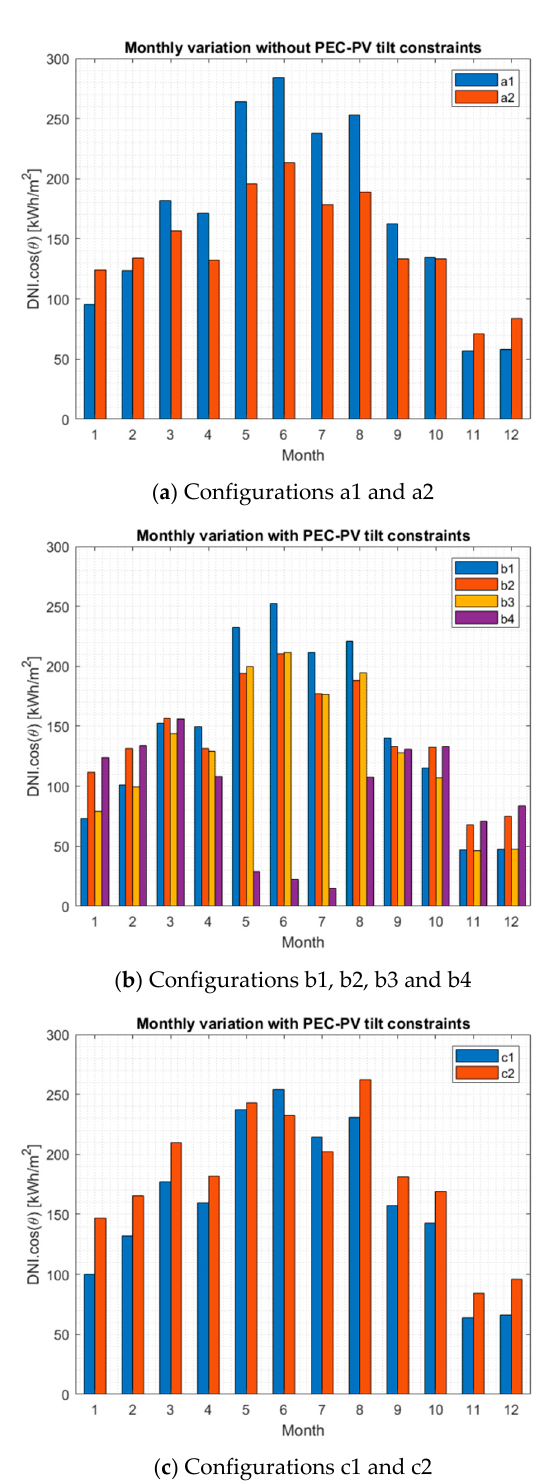
Figure A5. Yearly variation of DNI.cos( θ ) in kWh/m 2 for all geometrical configurations listed in Table 5, applying actual weather data and PEC(-PV) tilt constraints (20°–90°), where relevant. Site: Seville, Spain.